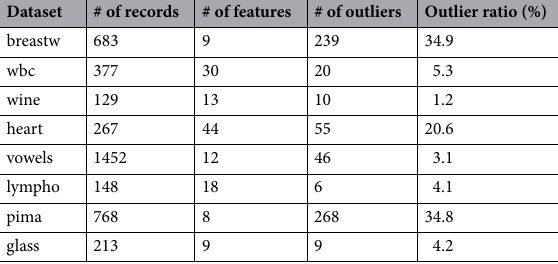
Table 1. Dataset statistics.